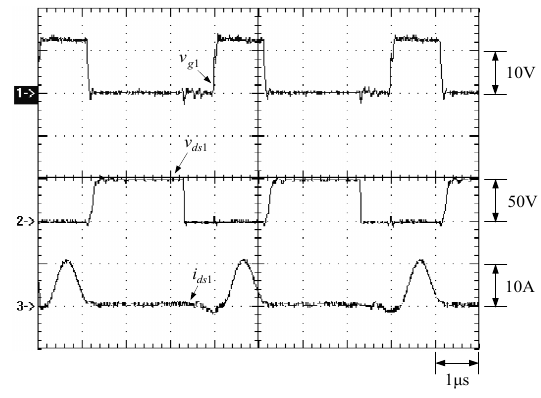
Figure 13. Waveforms relevant to S 1 : (1) v g 1 ; (2) v ds 1 ; (3) i ds 1 .